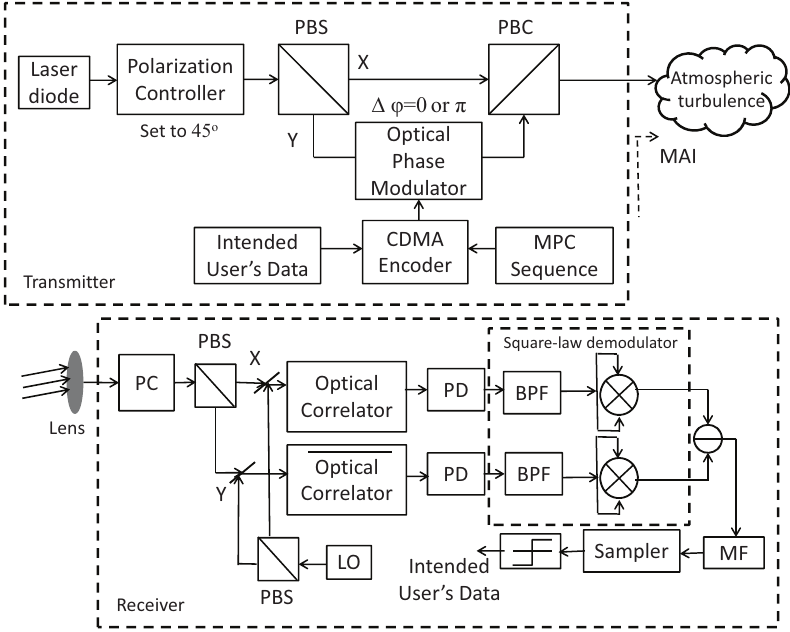
Figure 1. PolSK-optical code-division multiple-access (OCDMA) systems with heterodyne detection over turbulent FSO links. PD, photo-detector; BPF, band-pass